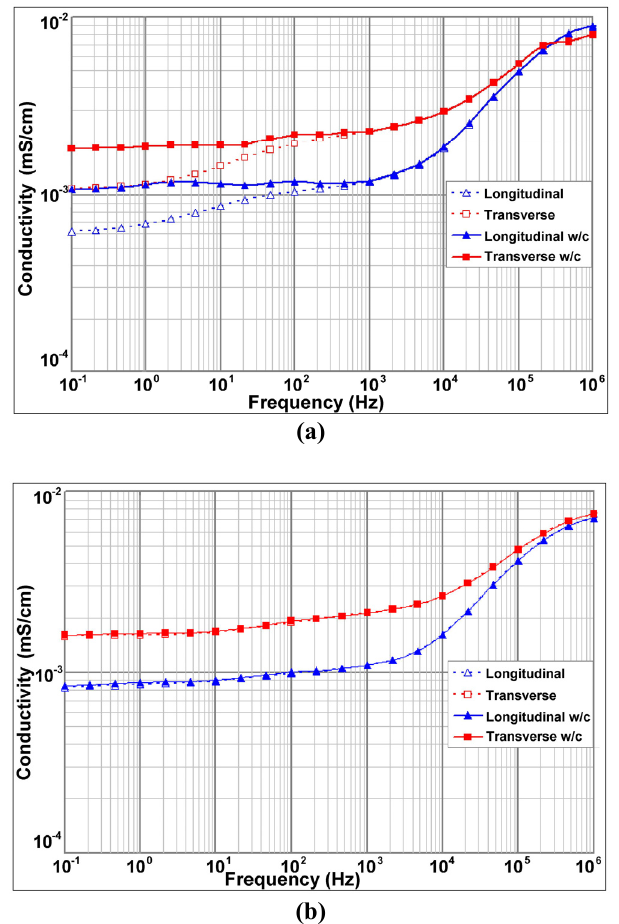
Figure 4: Muscle conductivity calculated with both respective equations. (a) Adjacent electrode, (b) concentric electrode, filled symbols are conductivity with correction by isopotential interface factor ( Δ : non adjusted longitudinal conductivity, □ : non adjusted transverse conductivity, ▲ : longitudinal conductivity with correction, ■ : transverse conductivity with correction).